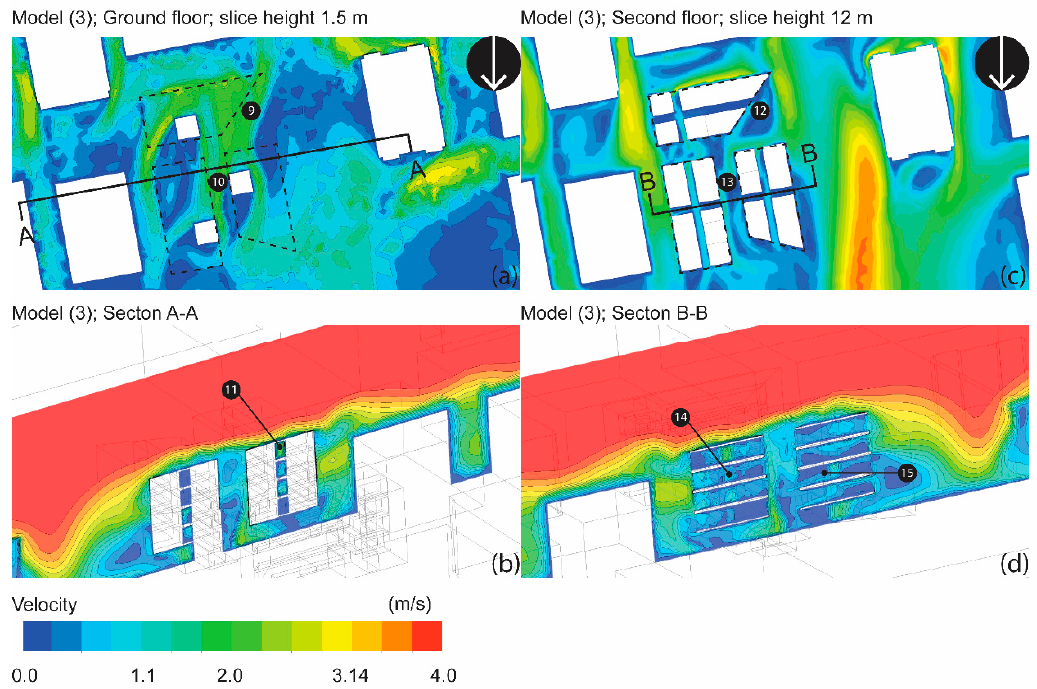
Figure 5. ( a , b ) Corridors provided with operable windows along the corridors; ( c , d ) potential of cross openings for increased wind flow.